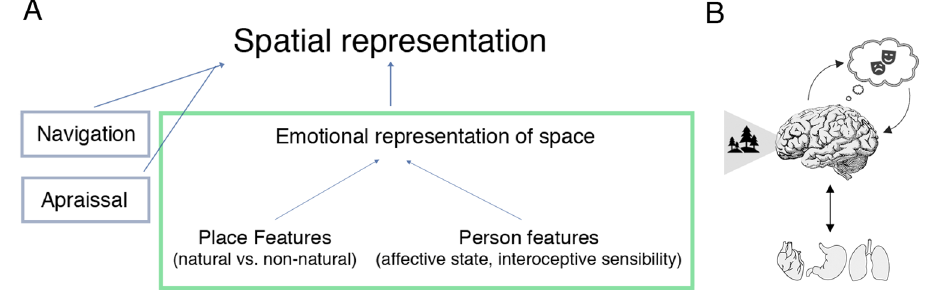
Figure 1. Framework and conceptualization. ( A ) People’s representation of space includes aspects related to navigation and appraisal. Yet, it is often overlooked that people have emotional experiences at different places, which create emotionally tinged representations of space. The current work (green box) examined these by considering that emotional representations are modulated by person and place features. The variables examined here (affective state, interoceptive sensibility, and natural vs. non-natural locations) reflect current models of human cognition. ( B ) Under these models, people’s emotional representations are accomplished by weighting bodily representations against value computations, namely, how we feel (based on past experiences and predicted needs) and what the environment can provide 12–14 . Icons in panel ( B ) are under Creative Commons license CC0 from